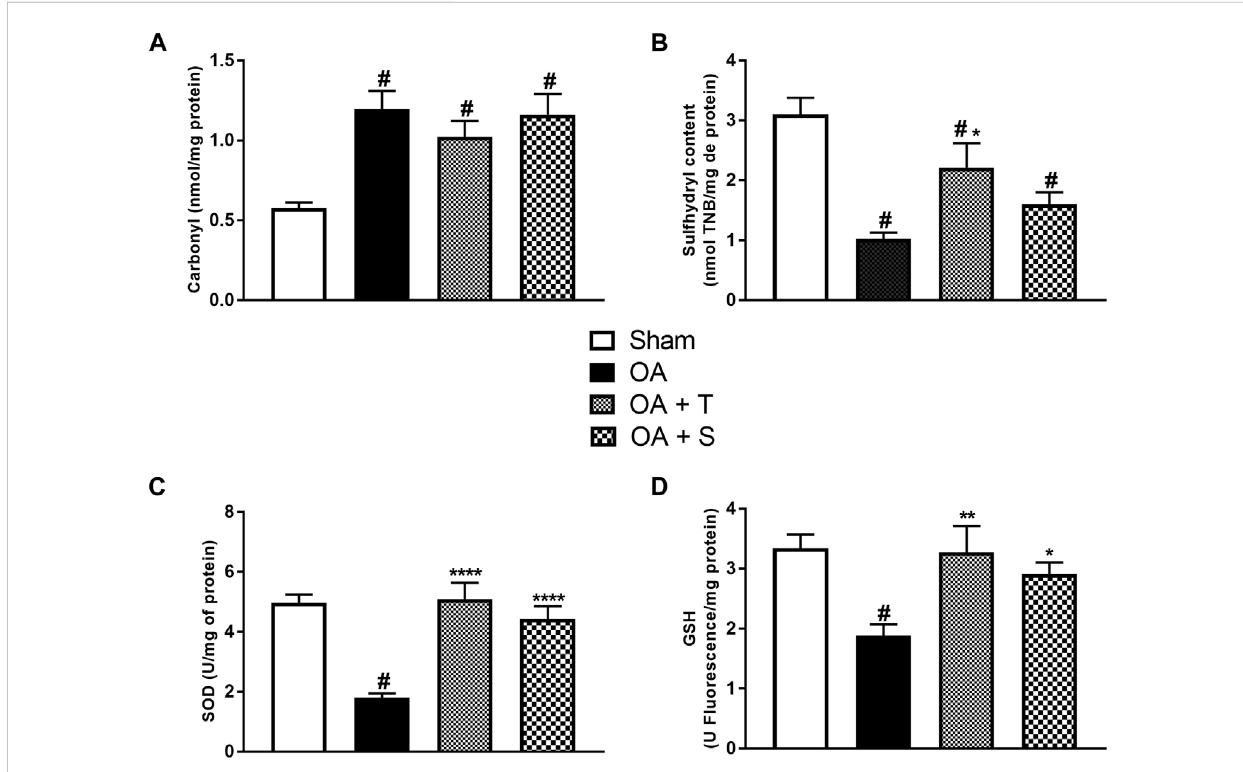
FIGURE 4 Oxidative damage and antioxidant system levels. (A) Carbonyl; (B) Sulfhydryl; (C) ; SOD; (D) GSH. Abbreviations: GSH, reduced glutathione; SOD, superoxide dismutase. Data are presented as mean ± SEM, in which: # p < 0.05 vs. Sham Group; * p < 0.05 vs. OA Group; ** p < 0.01 vs. OA Group; **** p